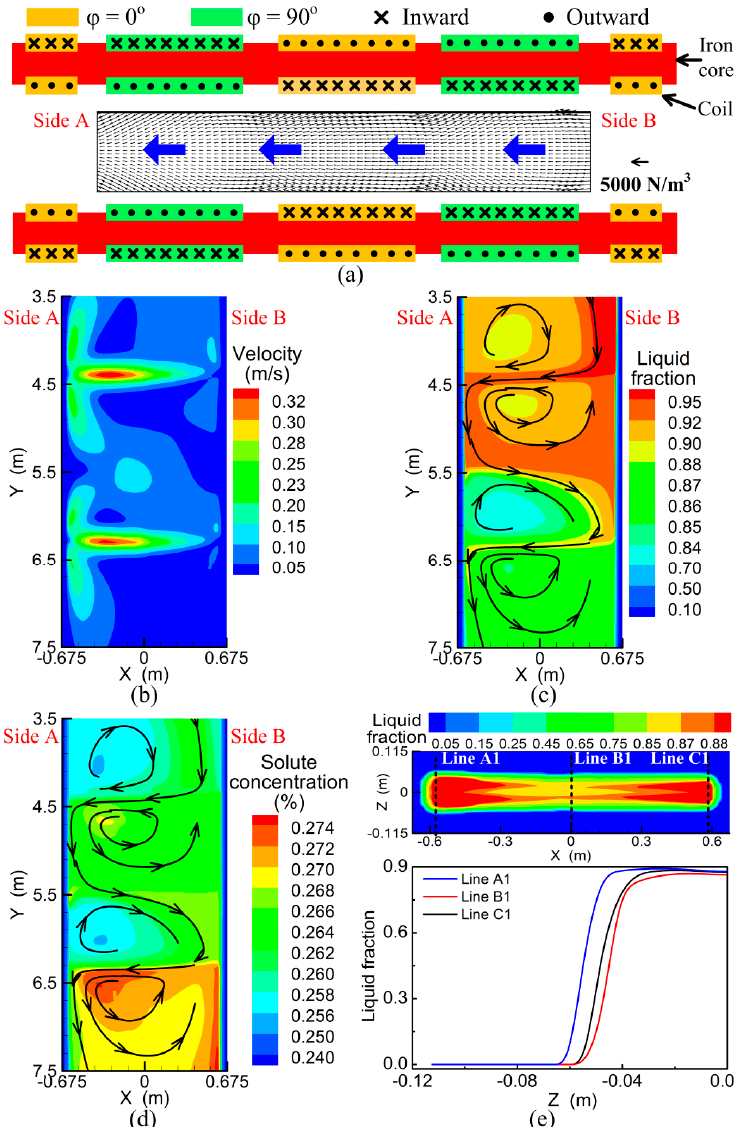
Figure 7. Electromagnetic force distribution and the applied current ( a ), fluid flow ( b ), liquid fraction ( c ), and solute concentration ( d ) in the stirring zone, and the liquid fraction distribution about 7 m from meniscus ( e ).